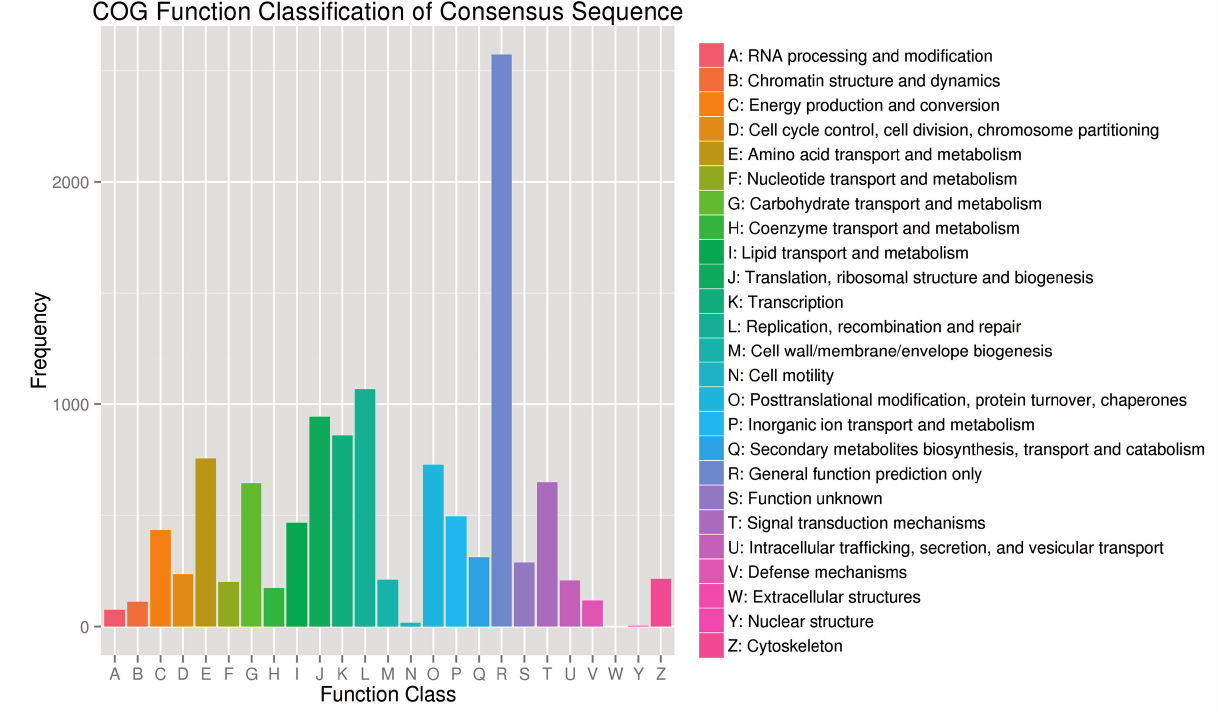
Figure 3. Clusters of orthologous group (COG) classification. A total of 8669 unigenes with non-redundant database hits were grouped into 25 COG